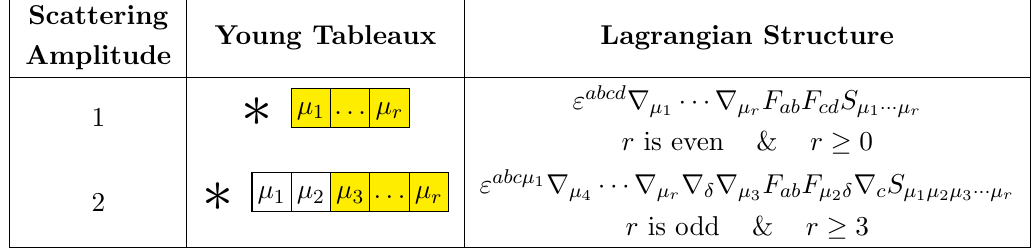
(cid:3) was explained in the caption to table